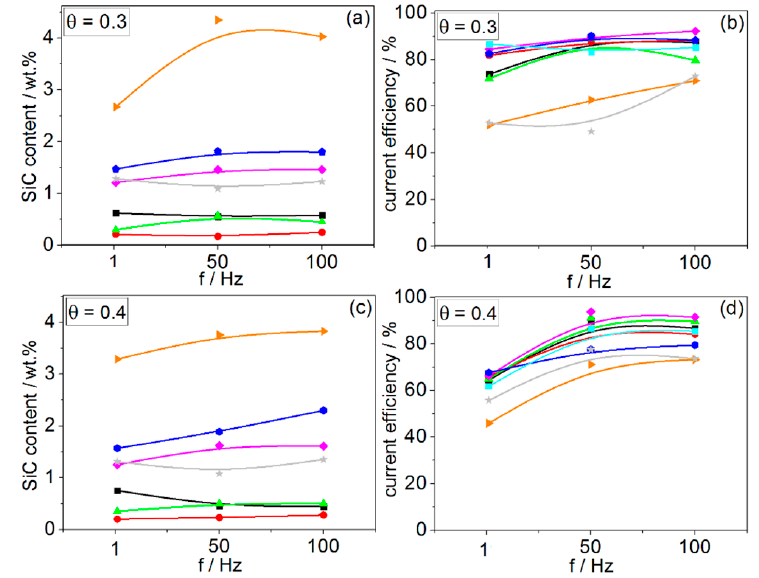
Figure 6. The effect of duty cycle in PED from electrolyte solutions with or without organic on the SiC content in the Zn–SiC deposit ( a , c ) and on the faradaic efficiency of the PED process at two selected frequencies–1 Hz ( a , b ) and 100 Hz ( c , d ).